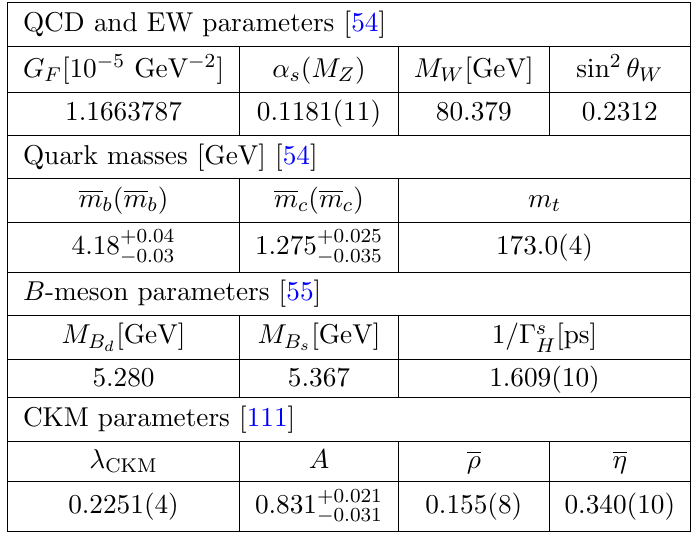
Table 1 . Summary of part of the input parameters used throughout this paper.